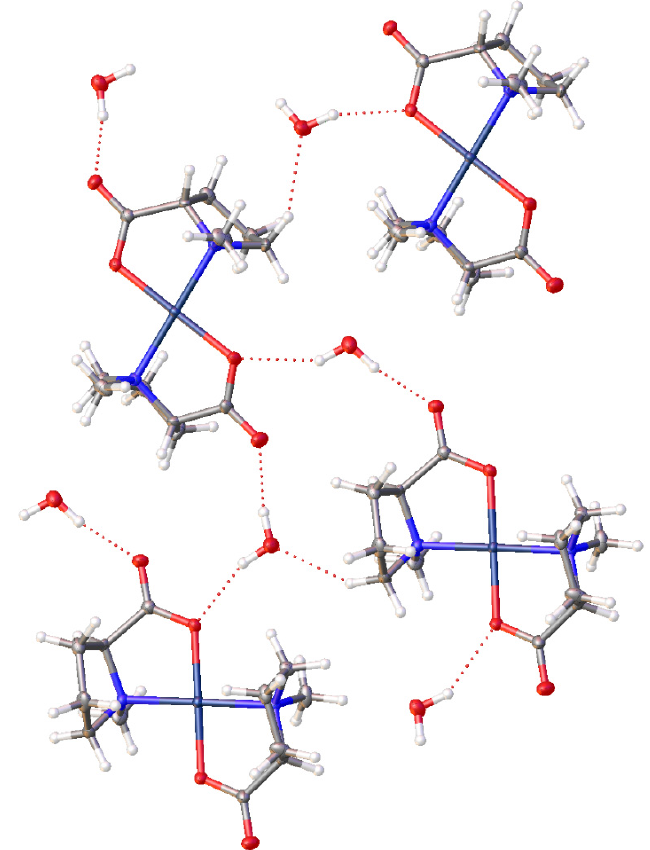
Figure 6. Crystal packing diagram of ( 2 ) as viewed along [010] showing the intermolecular hydrogen bonding motif.